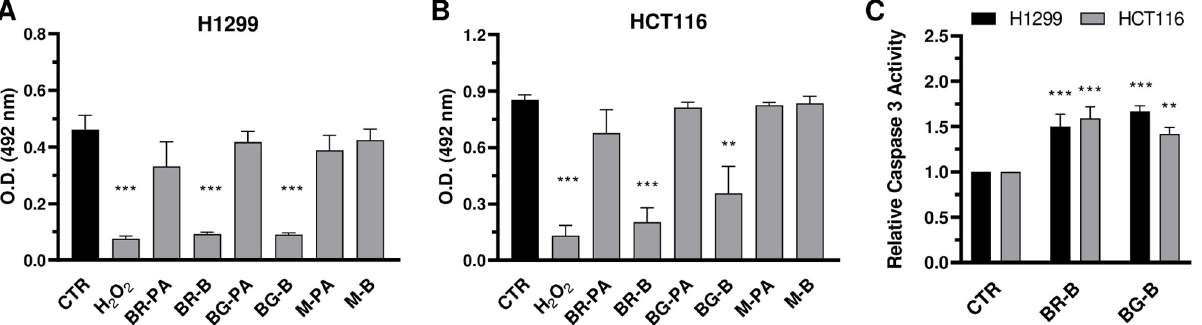
Fig 6. Characterization of cancer cell toxicity by different extracts from pomegranate immature and ripe fruits. Cytotoxicity after treatments with the indicated pomegranate fruit extracts (100 μ g/mL for 24 h) was assessed by MTS in H1299 ( A ) and HCT116 ( B ) cells. O.D., optical density; H 2 O 2 , positive control (100 μ M). (C) Caspase-3 activity induced by treatments with BR-B and BG-B (100 μ g/ml for 24 h) was quantified with the Ac- DEVD-AMC substrate. Results are fold changes relative to the respective vehicle DMSO. � , p � 0.05; �� , p � 0.01 and ��� , p � 0.001 vs respective vehicle DMSO. CTR, vehicle control